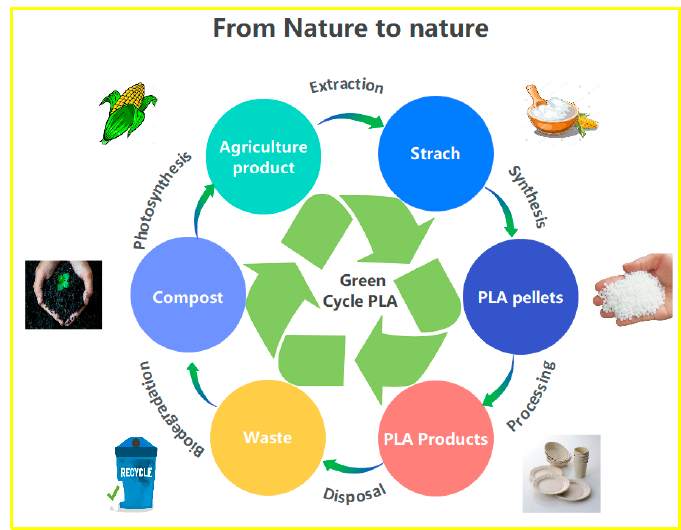
Figure 4. PLA’s life